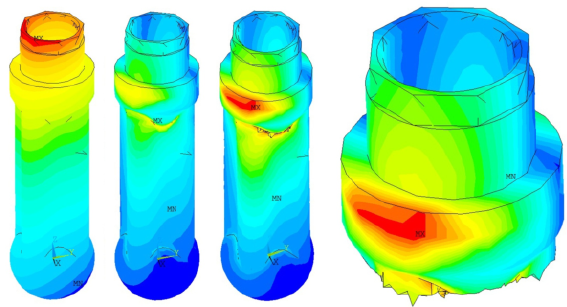
Figure 6. Numerical analysis of the reference implant 0001C: displacement – u lent von Mises stress σ